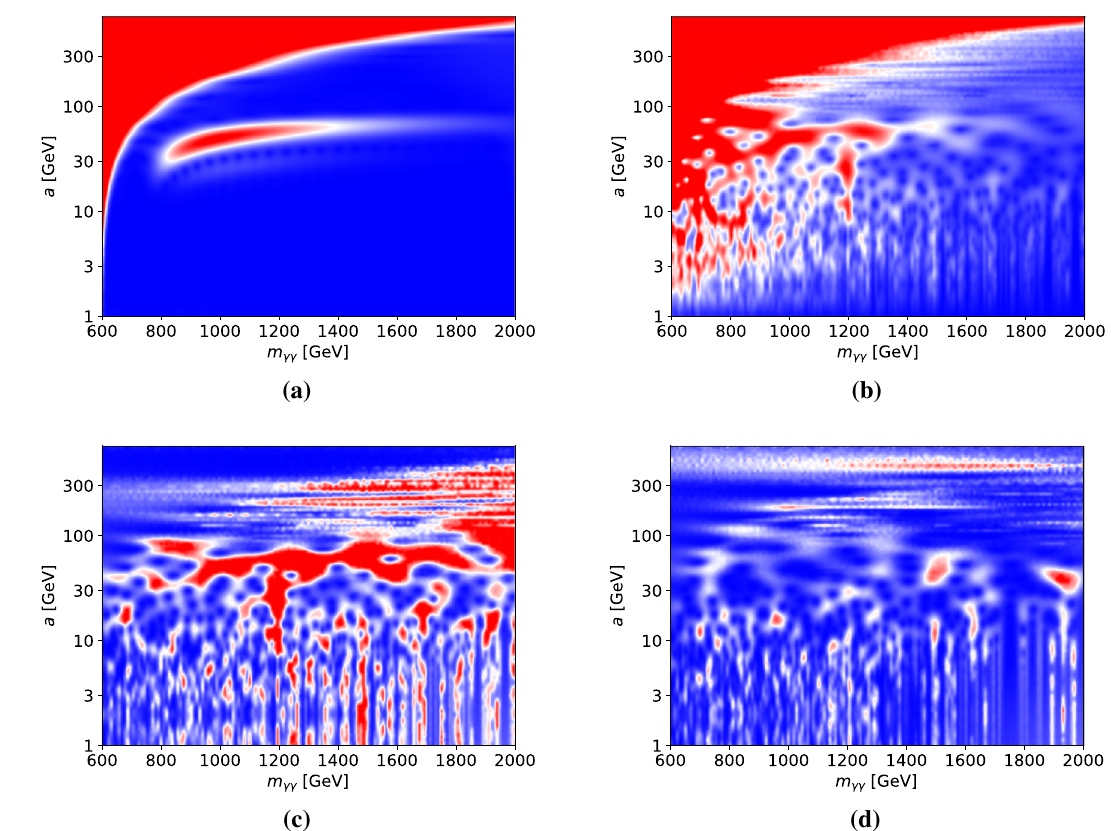
Fig. 4 Example of a the CWT of the expected signal and background, b the same CWT with statistical fluctuations, c the corresponding − ln p , and d − ln p of a typical background. The signal parameters used were k = 750 GeV and M 5 = 4